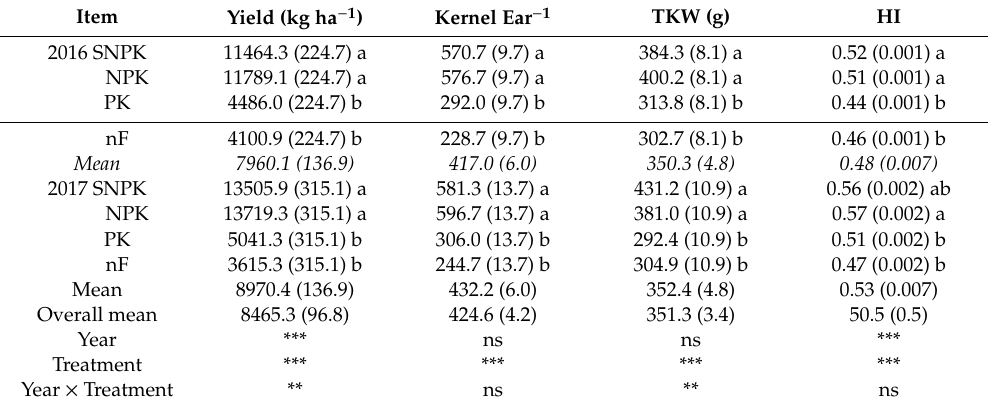
Table 3. Grain yield, kernel number per ear (kernel ear − 1 ), thousand kernel weight (TKW), and